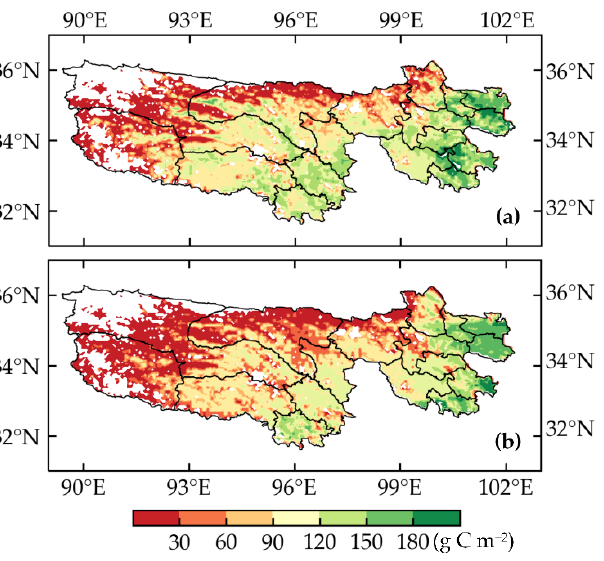
Figure 5. Maps of ( a ) MODIS-derived reference average AGB and ( b ) AVHRR-derived estimated average AGB with 5 km spatial resolution by GBRT model in the validation set during 2012–2013.